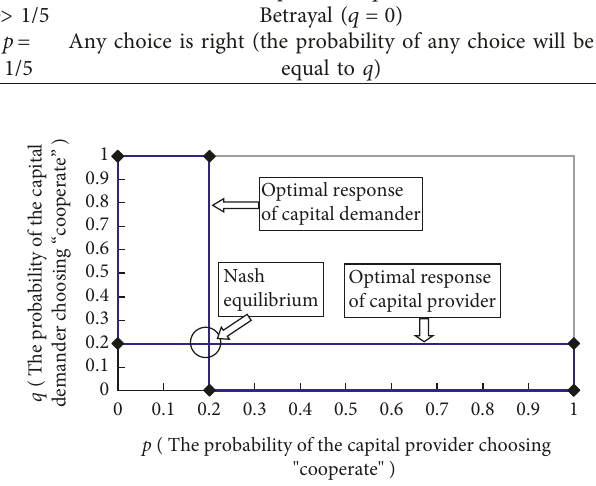
Figure 3: Optimal response strategy of game